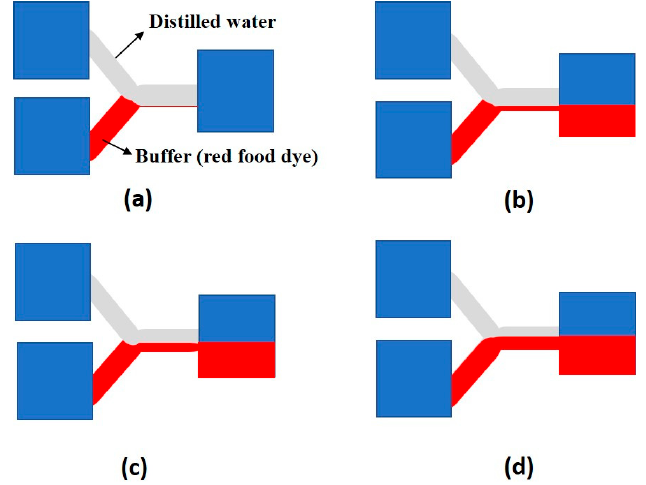
Figure 6. Schematic of different levels of the sample (distilled water) and the buffer (red food dye) in the common channel as per the ratio of the sample input pressure P s and the buffer input pressure P b in the device designed by Bragheri and Osellame. ( a ) (P s /P b ) = 1.85. ( b ) (P s /P b ) = 1.6. ( c ) (P s /P b ) = 1.2. ( d ) (P s /P b ) = 1.85. Redrawn from [63].